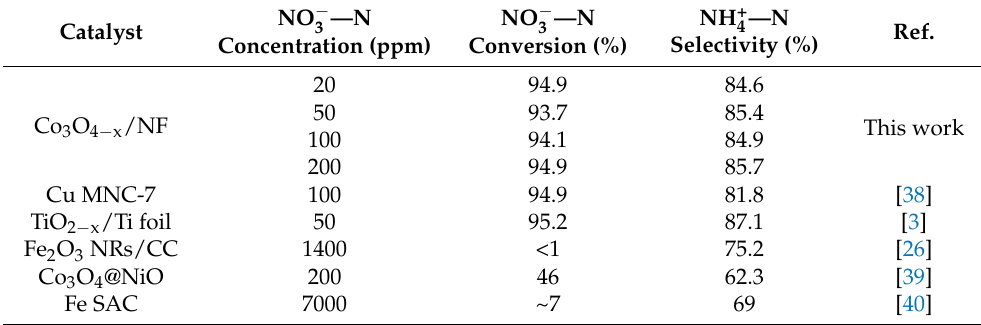
Table 2. Comparison of NO 3 RR performance between Co 3 O 4 − x /NF and reported catalysts.